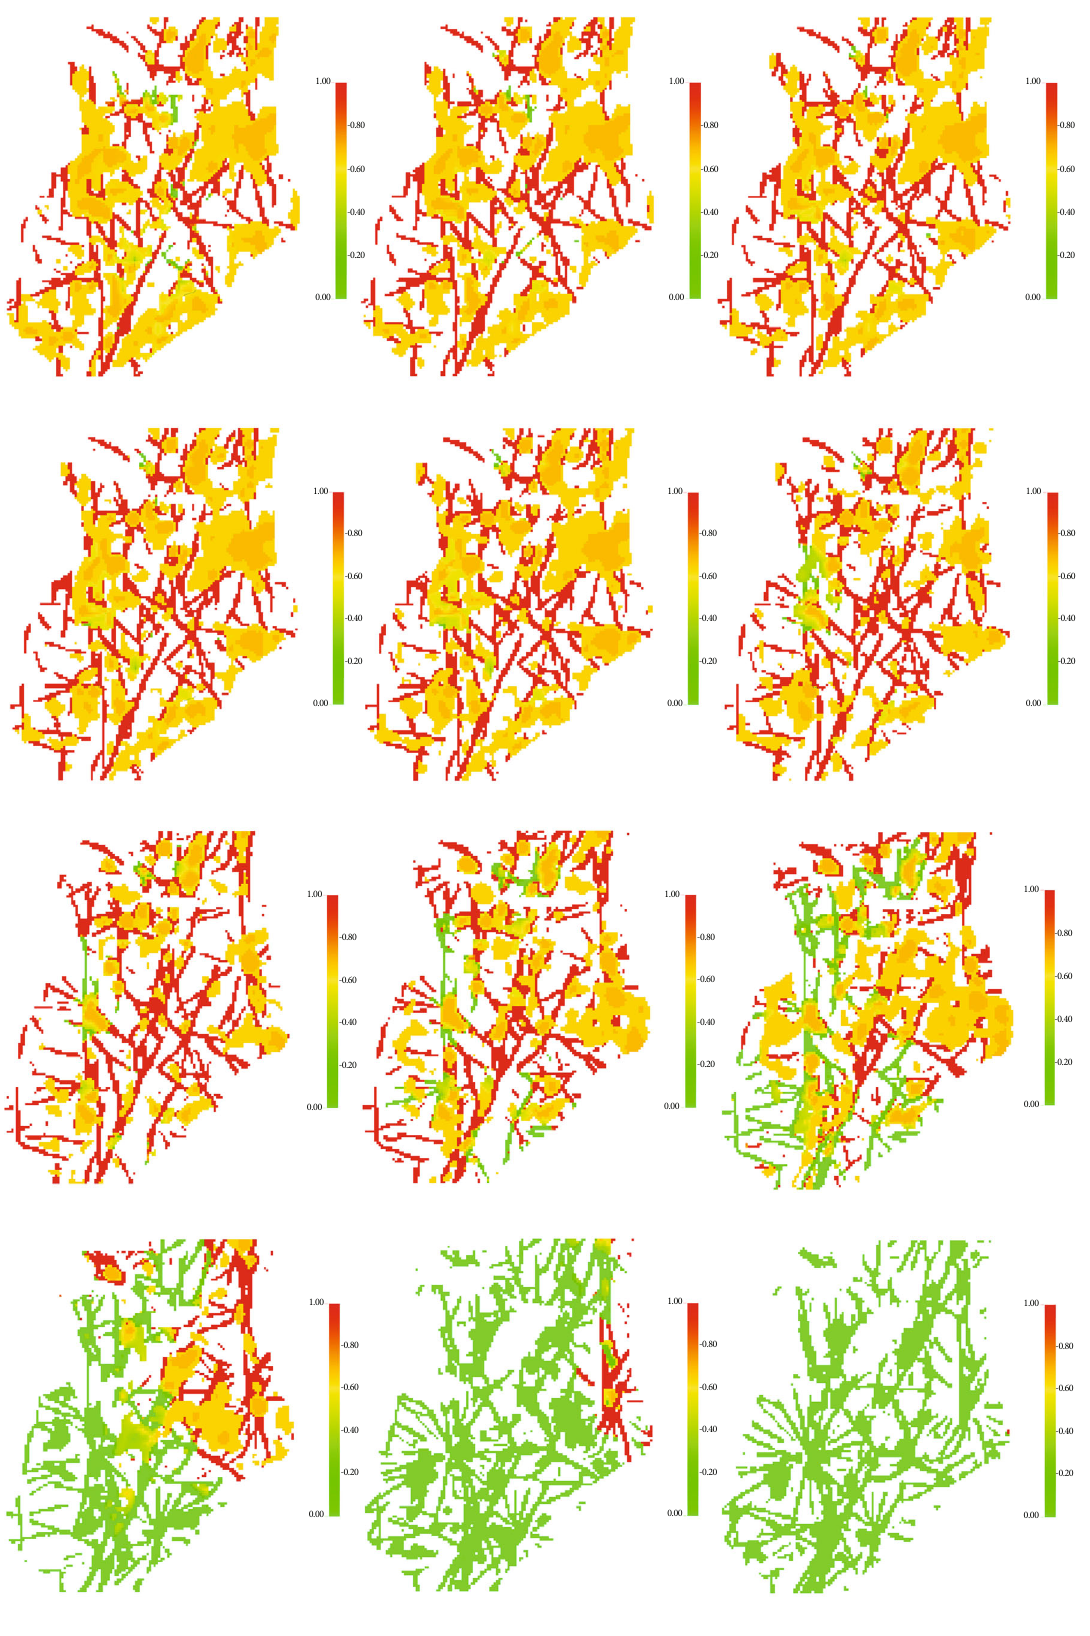
Figure 5: Residual oil distribution in di ff erent depth planes of the L11 unit (k from 1 to